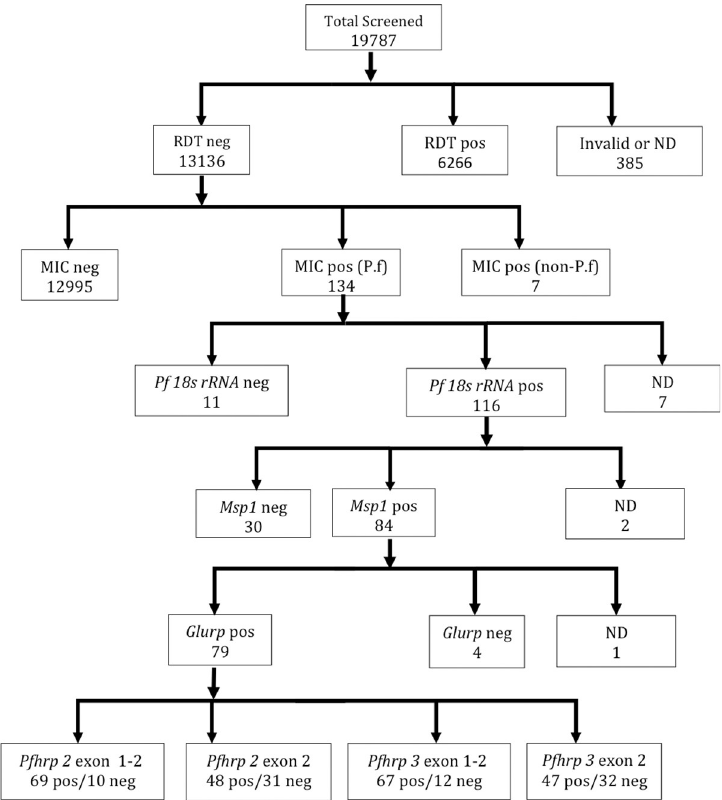
Fig 2. A flow chart illustrating sample processing. A schematic of the processes used to identify the false negative and subsequently the Pfhrp 2 and Pfhrp 3 gene deletion samples as well as the number of samples processed at each step. RDT, PfHRP 2 based malaria rapid diagnostic test kit; MIC, microscopy; pos, positive; neg, negative; ND, not